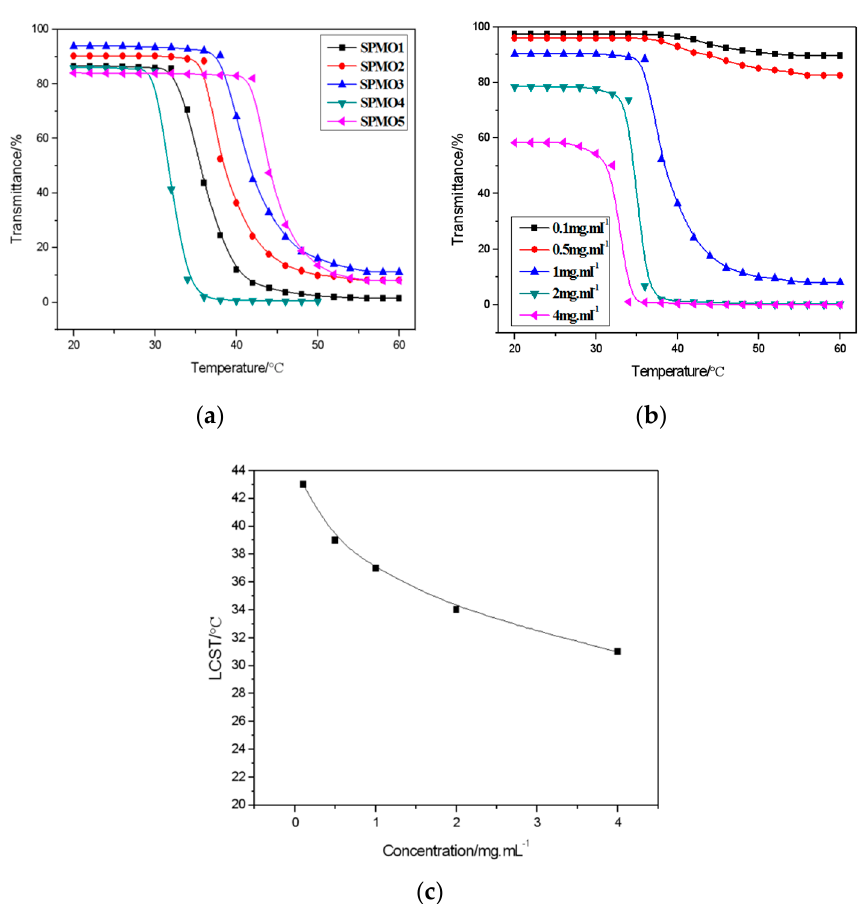
Figure 5. Curves of the triblock copolymers aqueous solutions transmittance versus temperatures with ( a ) different polymerization degree (DP) and the different content of OEGMA (1 mg/mL), ( b ) different concentrations, and ( c ) low critical solution temperature (LCST) versus the SPMO2 concentration.